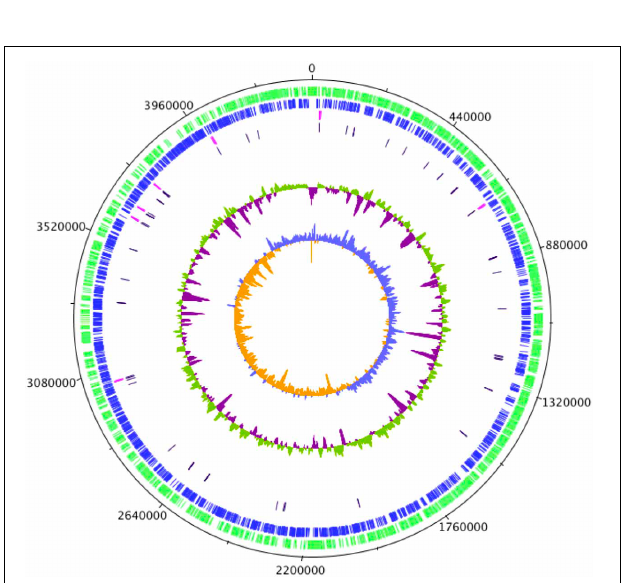
FIGURE A1 | Circular representation of the C. sakazakii SP291 genome. The first circle represents the scale in kilobases starting with the origin of replication at position 0. The second circle shows the distribution of CDS (Goldman and Green, 2009) in forward strand. The third circle indicates the distribution of CDS (blue) in reverse strand. rRNA operons are colored in red on the fourth circle. tRNA operons are colored in purple on the fifth circle. The sixth circle indicates the deviation of the GC content average, with values greater than zero in green and those less than zero in purple. The innermost circle displays the GC skew ([G + C]/[G − C]), with values greater than zero in light blue and those less than zero in orange. The figure was generated using DNAPlotter (Carver et al., 2009).